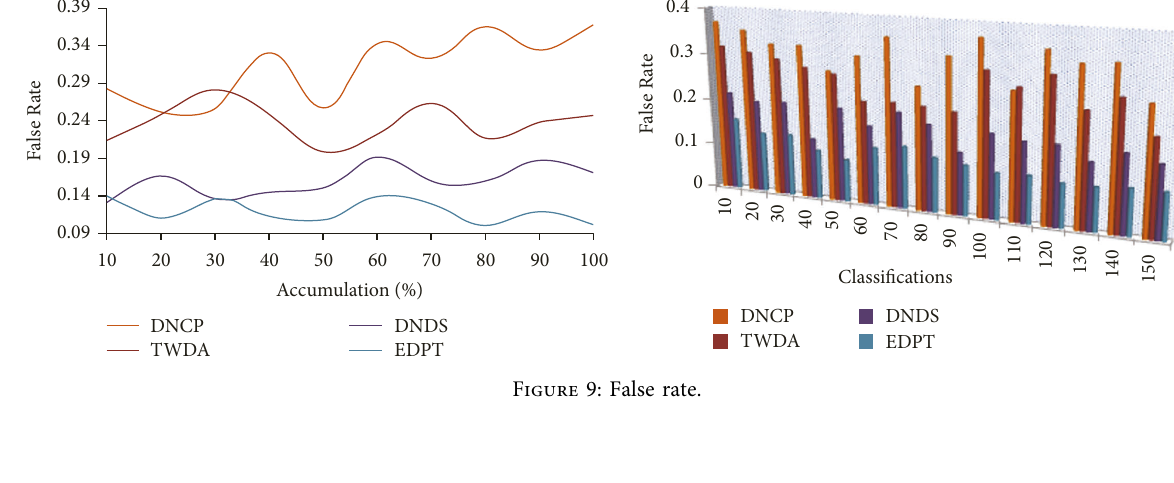
Figure 9: False rate.